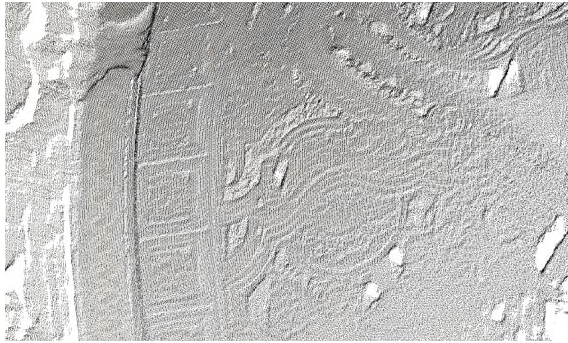
Figure 14 - Detail of the MicfMac model of a bowl-shaped vault